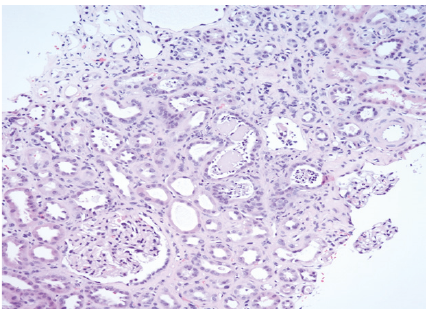
Figure 1: H&E section demonstrates fragments of fractured casts with neutrophilic reaction in a tubule. The glomeruli are unremark- able.